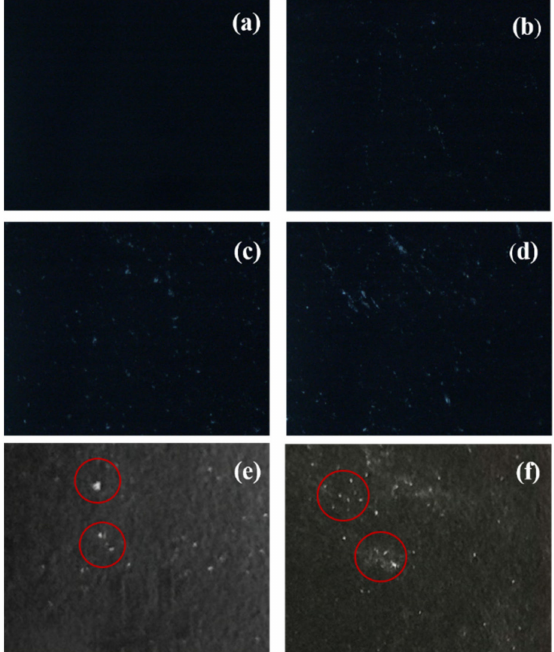
Figure 5. The appearance of the tape surface: ( a ) no sticking, ( b ) 1-time sticking, ( c ) 2-time sticking,